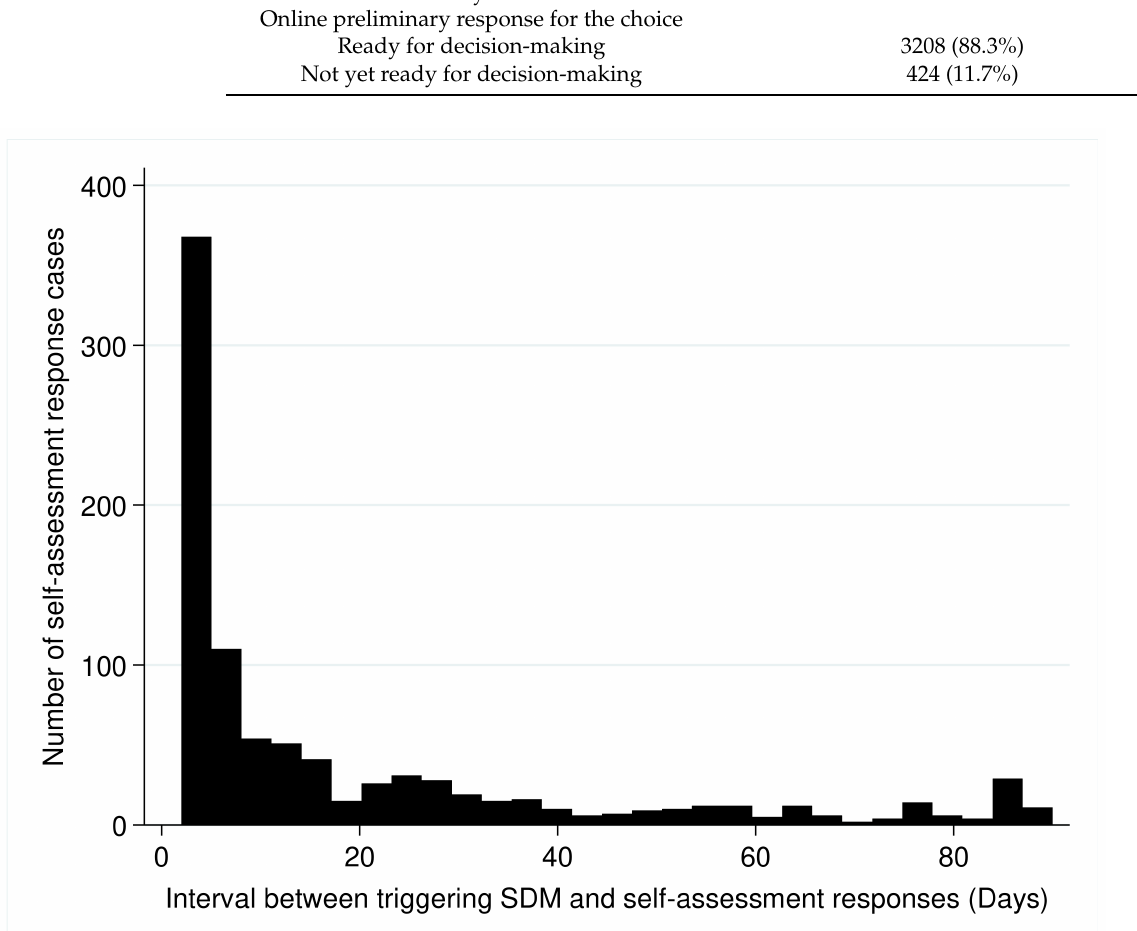
Figure 3. Distribution of intervals between triggering SDM and self-assessment responses in 933 cases of out-of-hospital